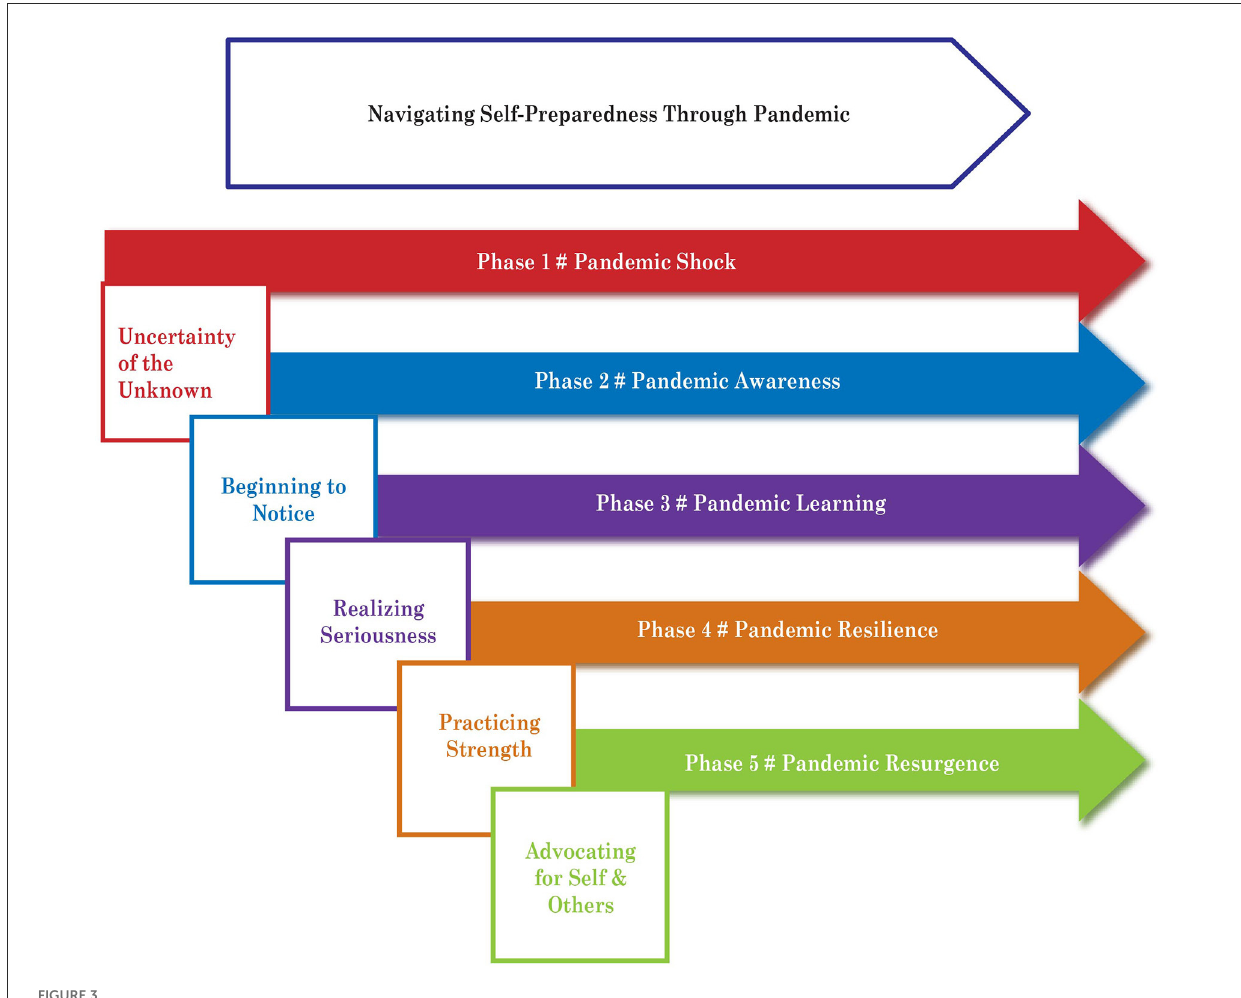
FIGURE3 Constructed